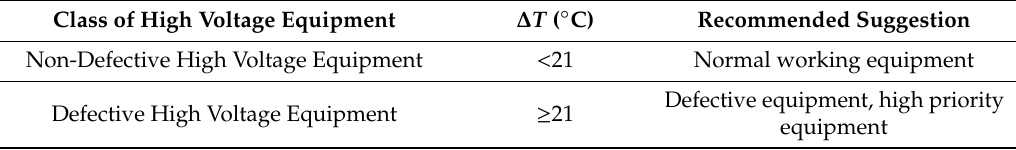
Table 1. Two classes of equipment with the recommendation.